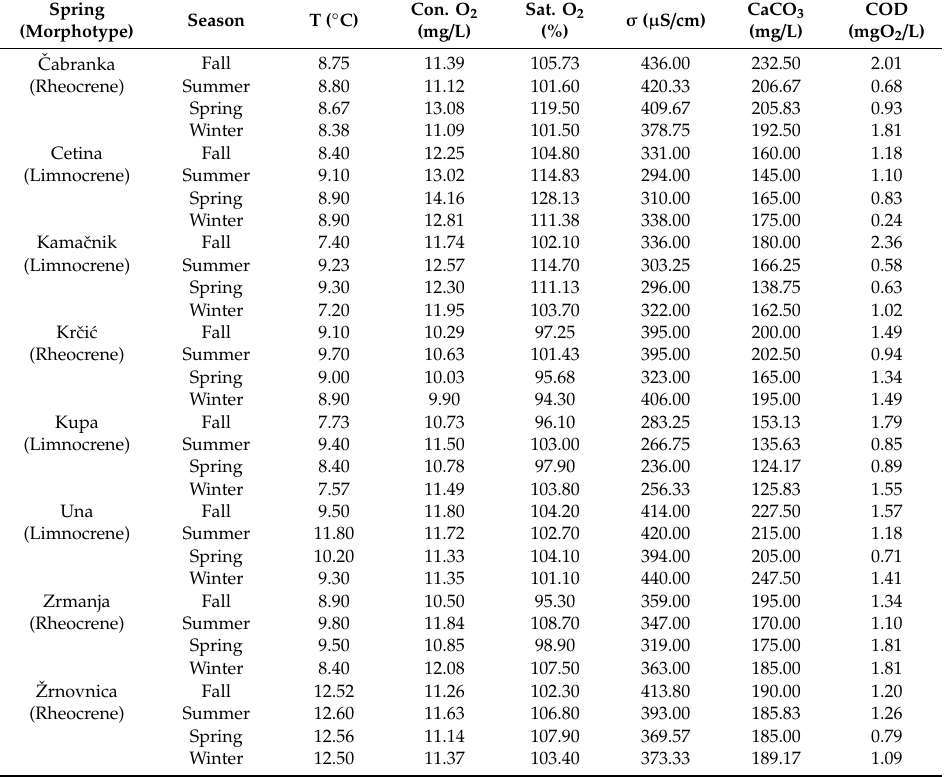
Table A1. Seasonal values of measured environmental variables in the studied limnocrenes and rheocrenes. (T = water temperature, con. O 2 = oxygen concentration, sat. O 2 = oxygen saturation, σ = conductivity, CaCO 3 = calcium carbonate concentration, COD = chemical oxygen